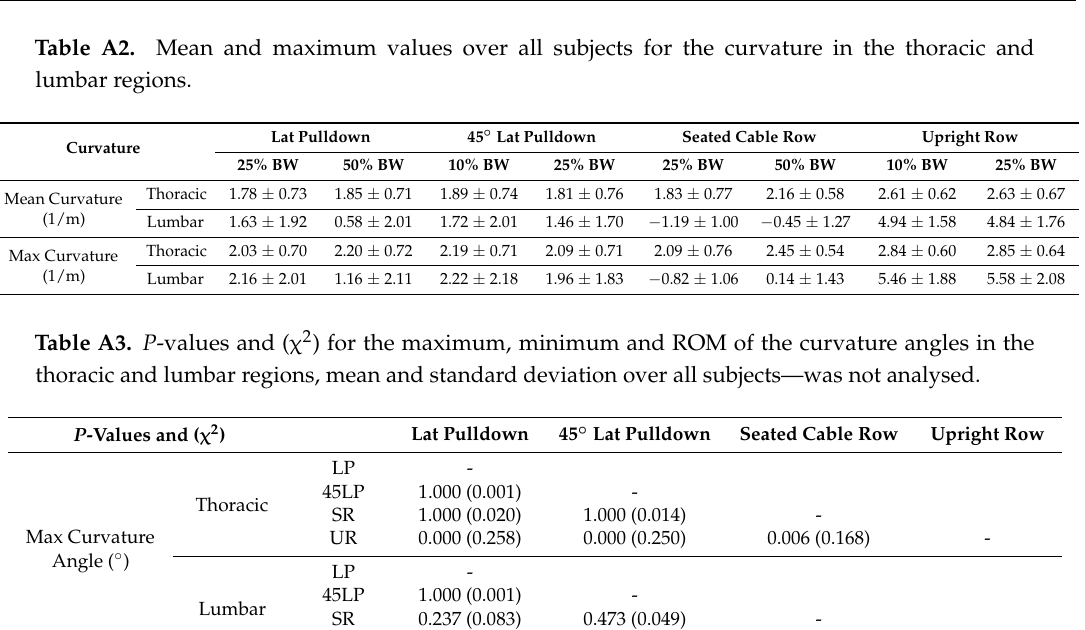
Seated Cable Upright Row Row